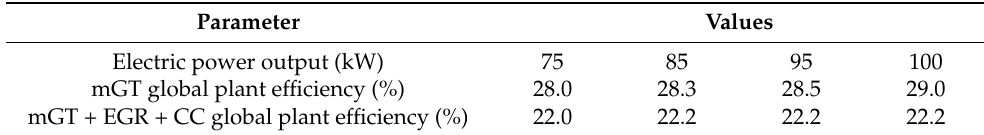
Table 2. Comparison of the global plant efficiency with EGR and CC and traditional mGT efficiency (adapted from [67]). Parameter Values Electric power output (kW) 75